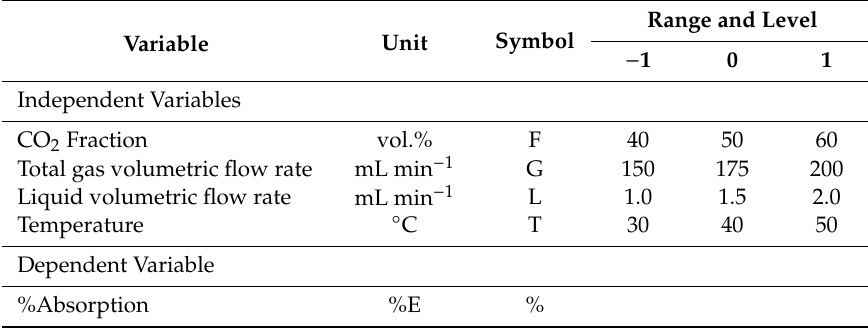
Table 1. Experimental range of absorption variables.